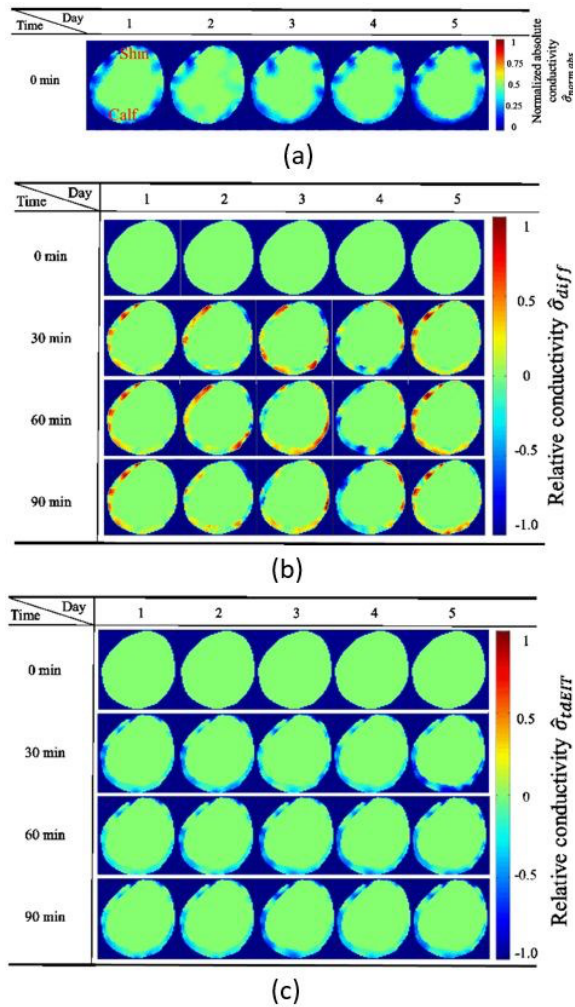
Fig. 4. (a) the normalized absolute conductivity distribution of the right lower leg (viewed from the top) reconstructed by absolute EIT at 1 st measurement; These are used as inhomogeneous reference data in (b). Time series of reconstructed relative conductivity distribution using the image-based reference EIT (b) and conventional time difference EIT (c) at 2 nd , 3 rd , and 4 th measurement,